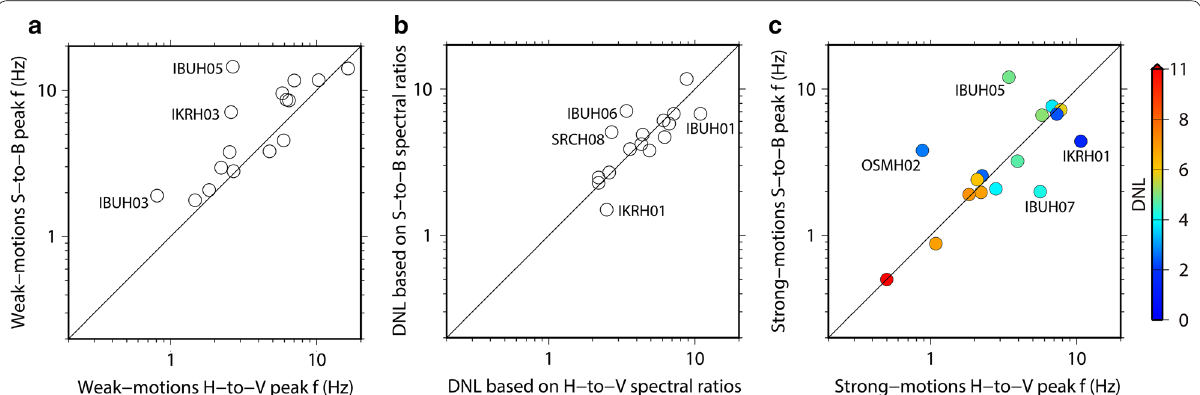
Fig. 13 a Comparison of peak frequencies between S-to-B spectral ratios for horizontal components (H-to-H) and horizontal-to-vertical (H-to-V) spectral ratios at the surface for weak-motions. b Comparison of DNL values based on S-to-B spectral ratios for horizontal components (H-to-H) and H-to-V spectral ratios at the surface. c Comparison of peak frequencies between S-to-B spectral ratios for horizontal components (H-to-H) and H-to-V spectral ratios at the surface for strong-motions. The data points are color-coded by DNL values based on the S-to-B spectral ratios. Some data points that deviate largely from the diagonal lines are provided with their site codes near the data